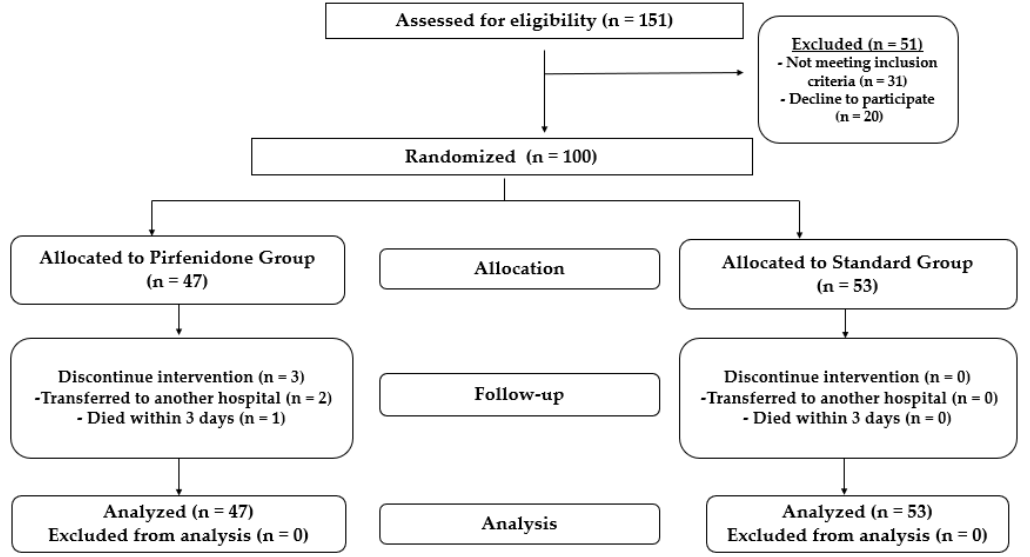
Figure 2. Flow chart showing the study design and patient randomization. Table 1. Baseline and Demographic Data for Recruited Patients in Both Groups. Parameters